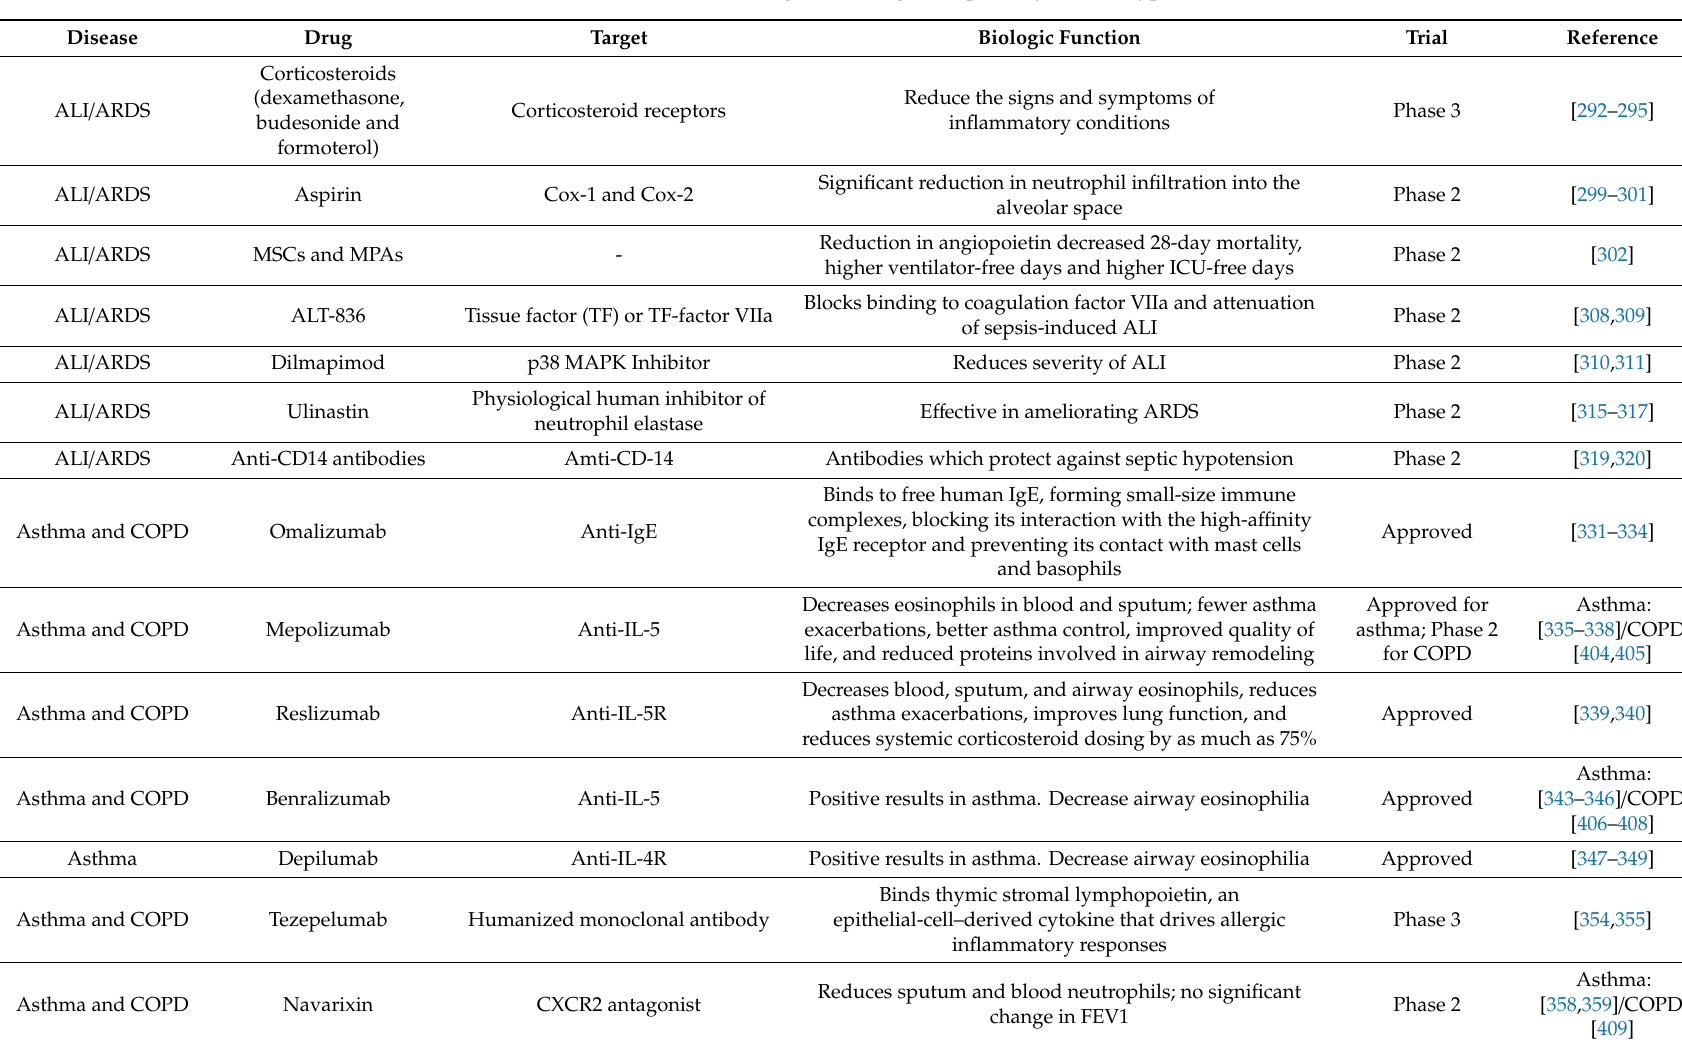
Table 1. Most relevant drugs according to respiratory disease